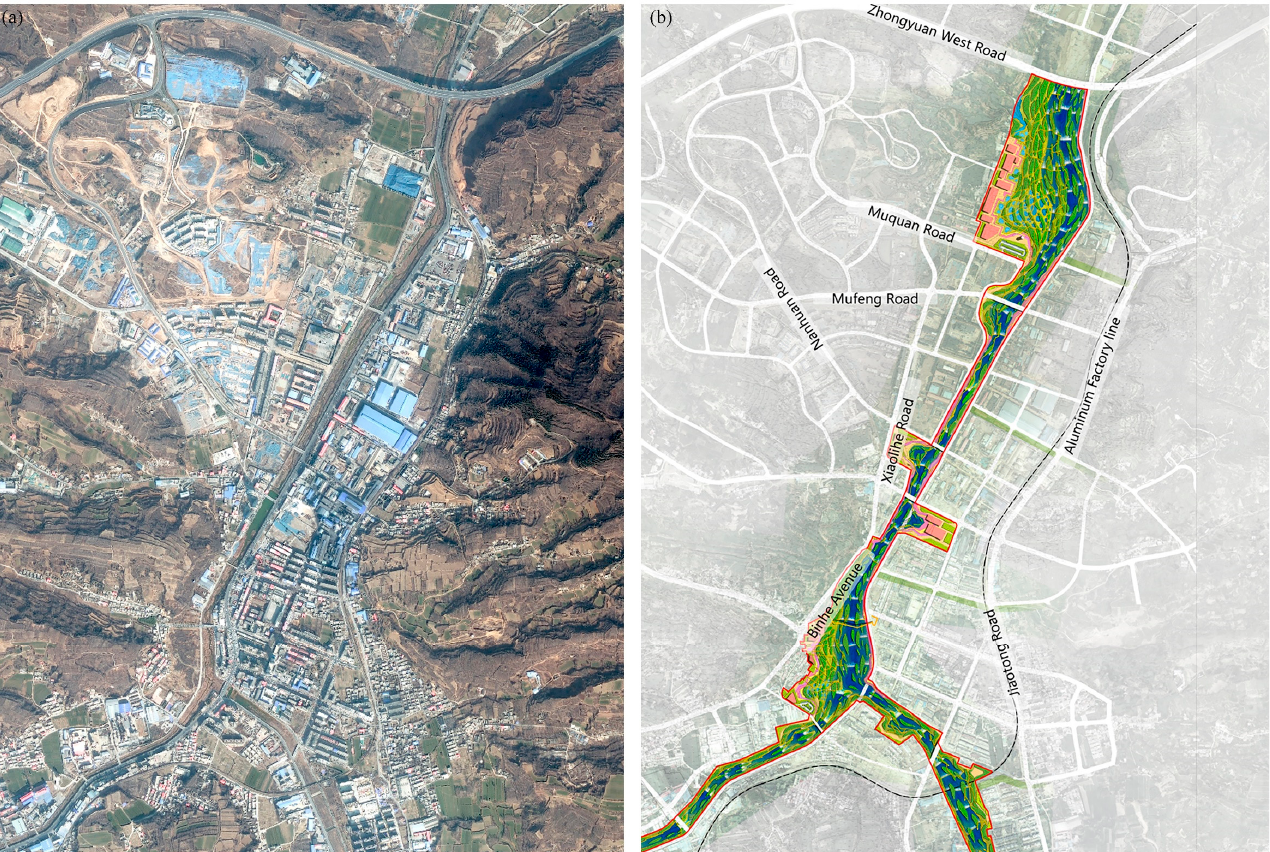
Figure 9. Master plan of the core region before ( a ) and after ( b ) the intervention. (Source: Turenscape Urban Planning and Design Co., Ltd.)